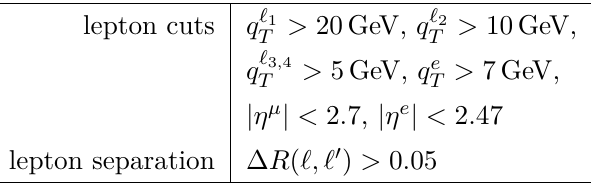
Table 4 . Setup for the ATLAS ZZ analysis at measured by the